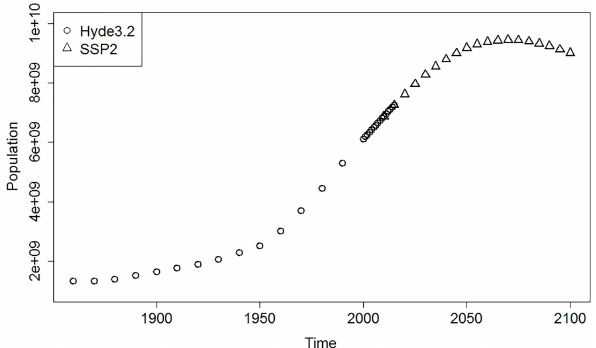
Figure 5. Time series of global population for the historical period (dots) and future projections following the SSP2 storyline (trian- gles).